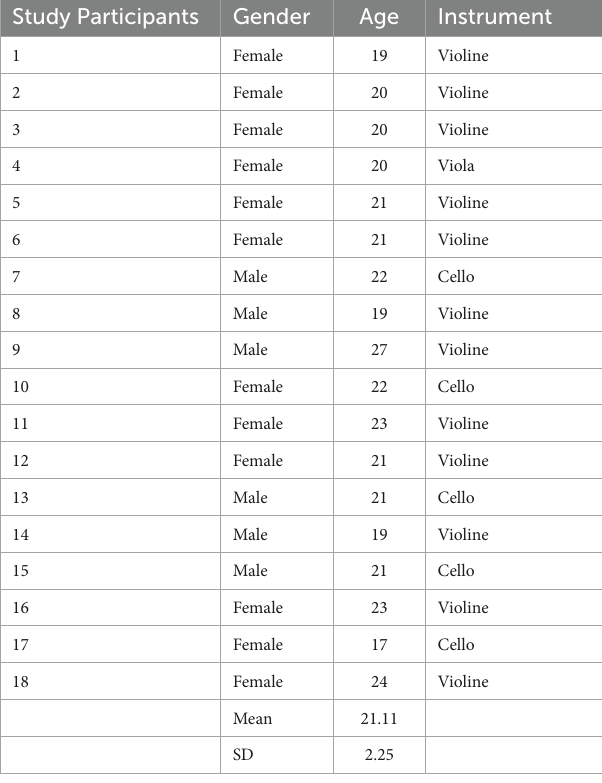
TABLE 1 Demographic data of participants.